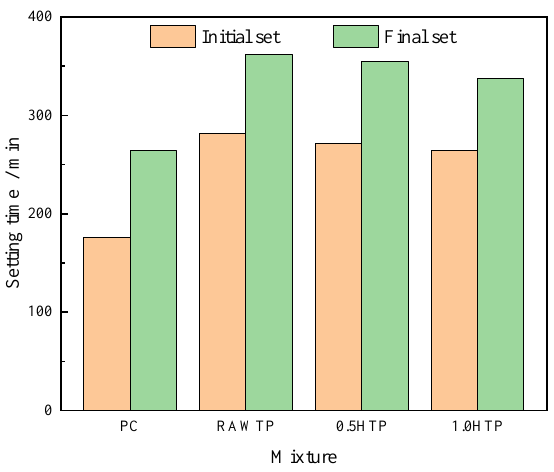
Figure 9. Setting times of cementitious pastes.